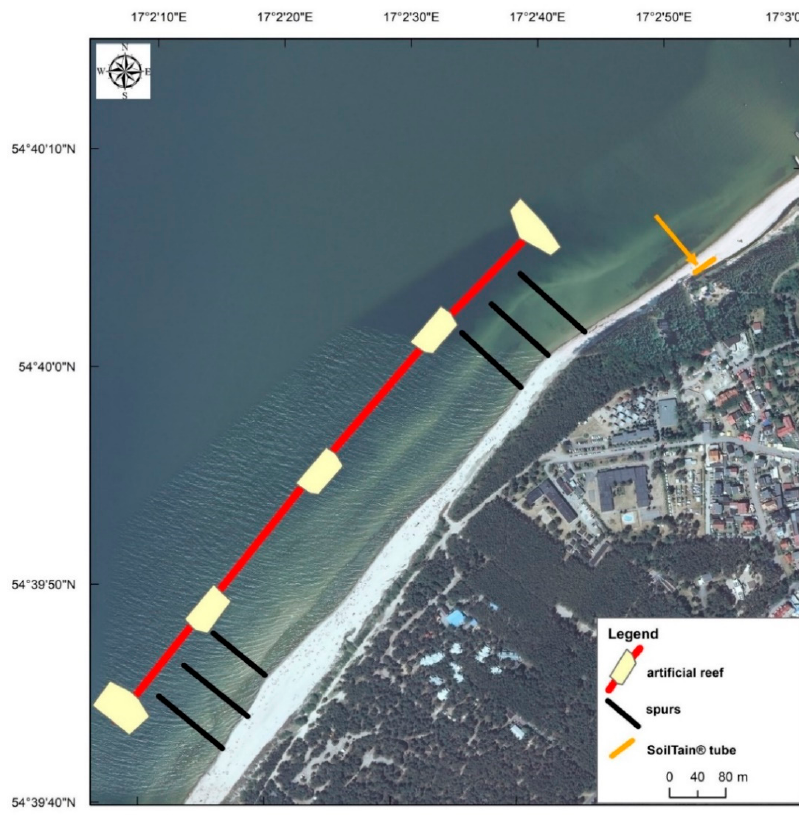
Figure 2. Types of protective elements used on the beach in Rowy.